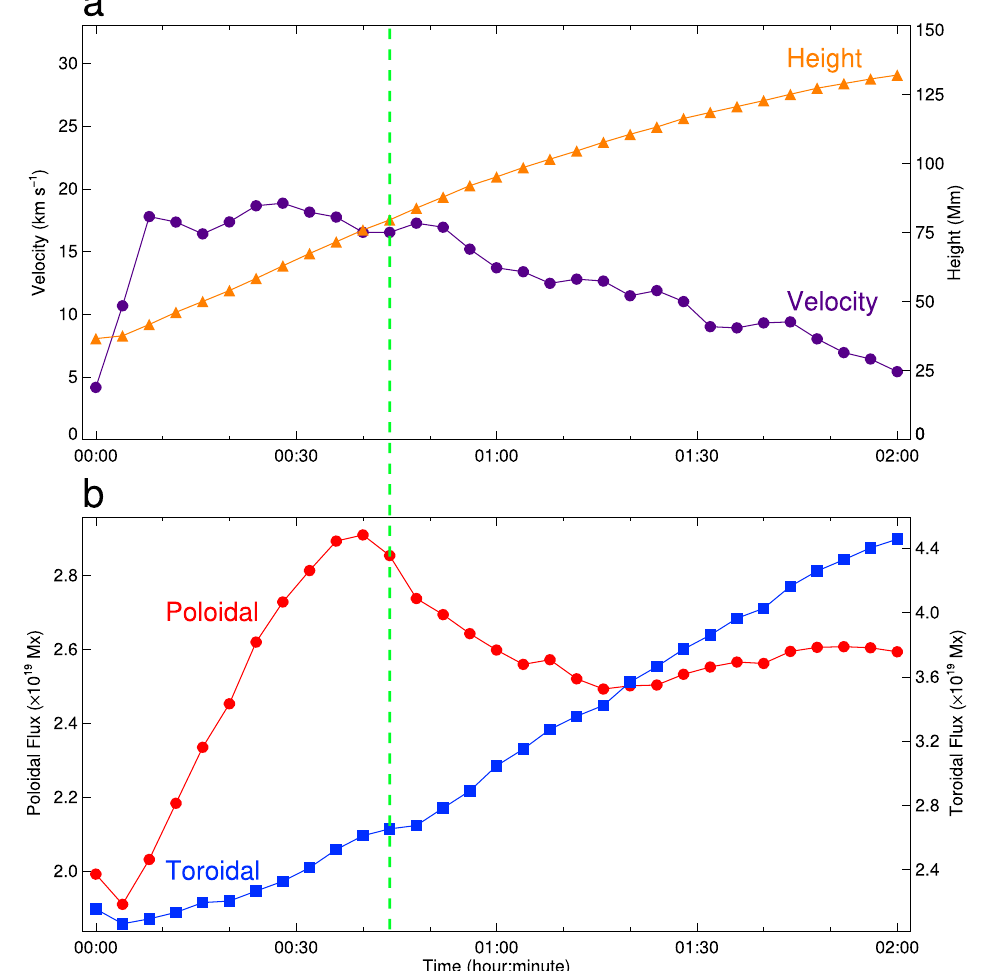
Fig. 5 Kinematics and magnetic fl uxes of the MFR. a Time – height measurement of the MFR in the MHD simulation. The orange triangles and purple circles show the height and velocity, respectively. b Temporal evolutions of the toroidal fl ux (blue squares) and poloidal fl ux (red circles) of the MFR. The green dashed line represents the peak time of the M2.0 fl are at 00:44